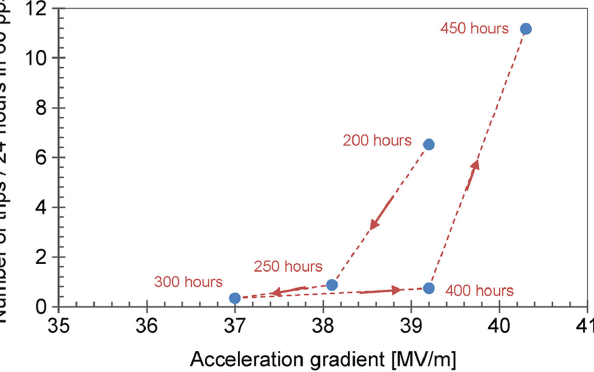
FIG. 14. Record of the trip rates during high-power rf con- ditioning at the test